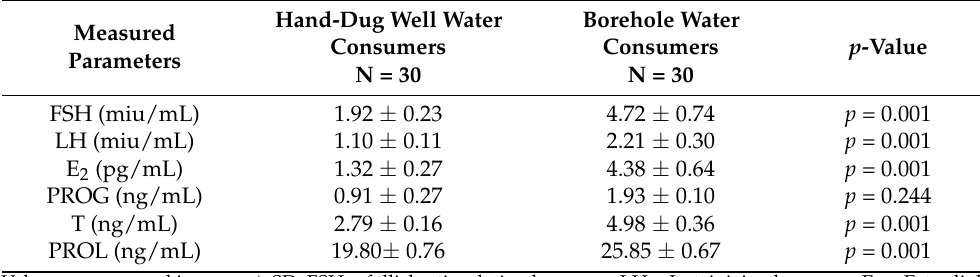
Table 6. Serum Hormone Levels among Hand-Dug Well and Borehole Water Consumers.